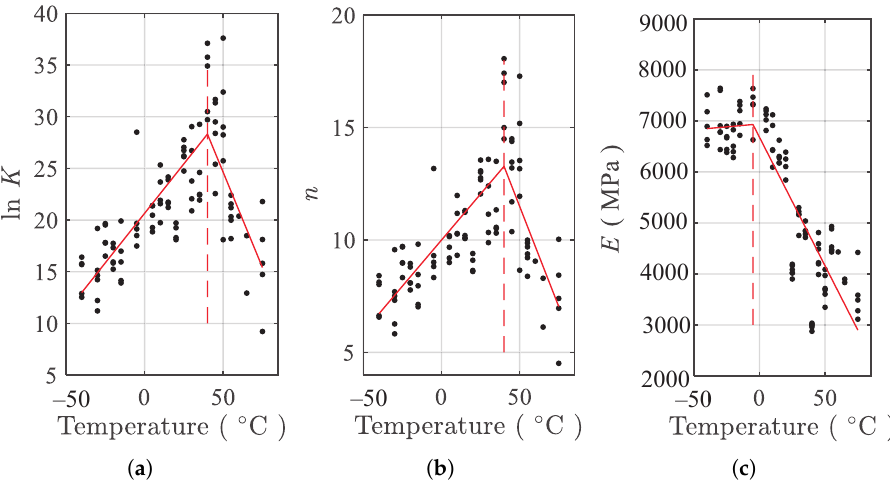
Figure 10. Temperature dependence of parameters under compression. ( a ) ln K , ( b ) n , and ( c ) E . Similar to the tension results, the variation of parameters with the temperatures under compression are also piecewise linear. Both ln K and n are linear proportional to the temperature in the range of − 40–40 ◦ C. In the range of 40–75 ◦ C, the two parameters are inversely proportional to the temperature. The parameter E shows the same behavior but with a different change point of − 5 ◦ C. Therefore, for compression data, the same equation, Equation (3), is used with T k 1 = T k 2 = 40 ◦ C and T k 3 = − 5 ◦